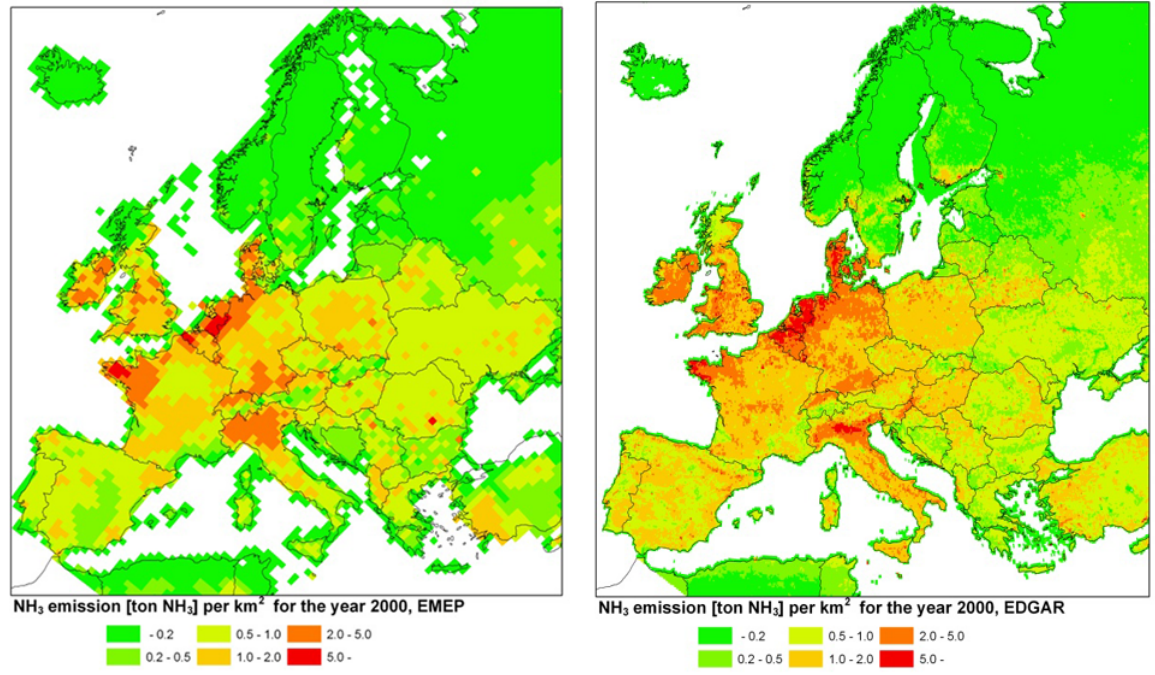
Fig. 4. Spatial distributions of annual NH 3 emissions in Europe for the year 2000 based on: (left) EMEP at 50km × 50km to the (right) EDGAR at 0.1 ◦ × 0.1 ◦